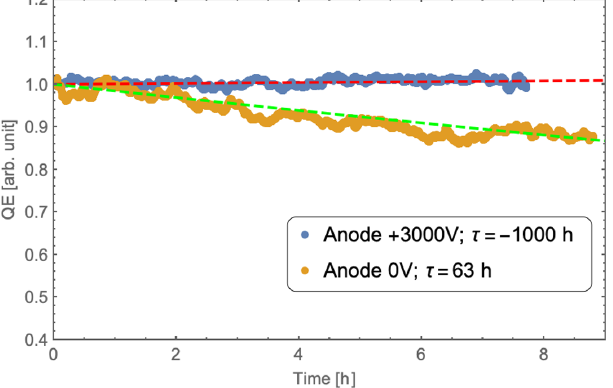
FIG. 10. Comparison of QE decay between unbiased anode and biased anode operation. The peak and average current in both cases were the same — 3.5 A and 37 . 5 μ A, respectively. The τ is the decay time using exponential fitting. The negative τ means the QE had slightly increased in 8